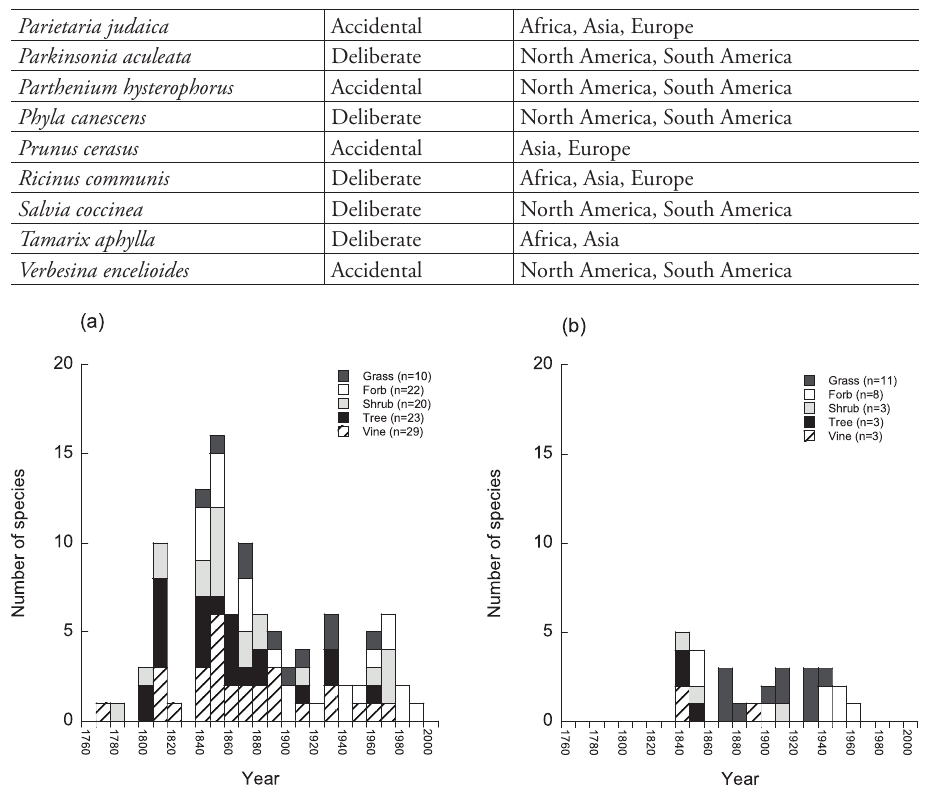
Figure 3. Frequency distributions of a deliberate and b accidental introduction times of invasive alien plant species in Australia in relation to plant growth